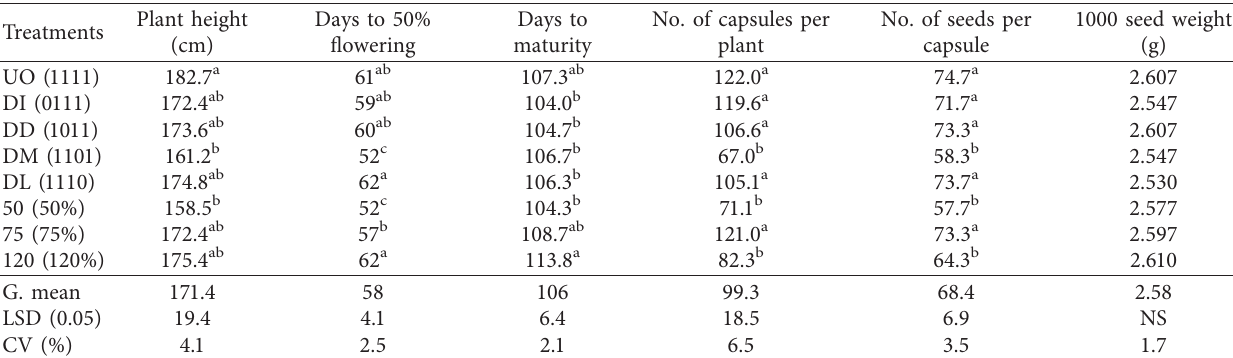
Table 5: Plant height, phenological stages, and yield component of sesame as influenced by different levels of irrigation.